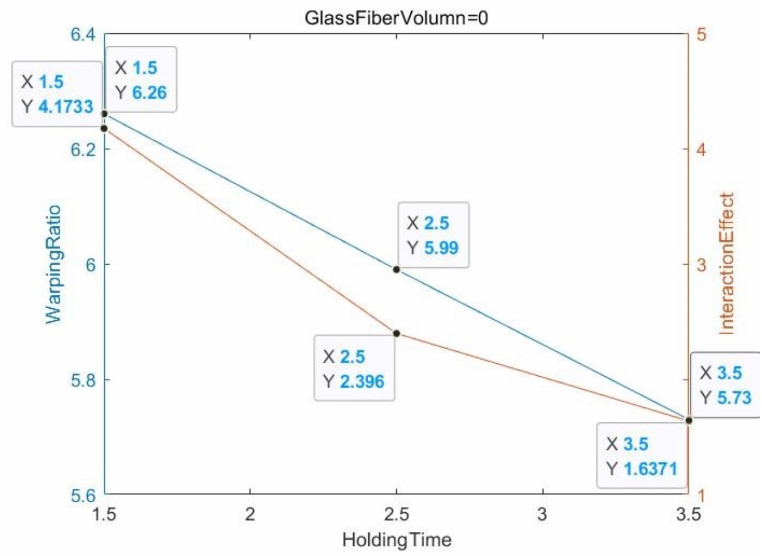
Figure 6. GF Volume =